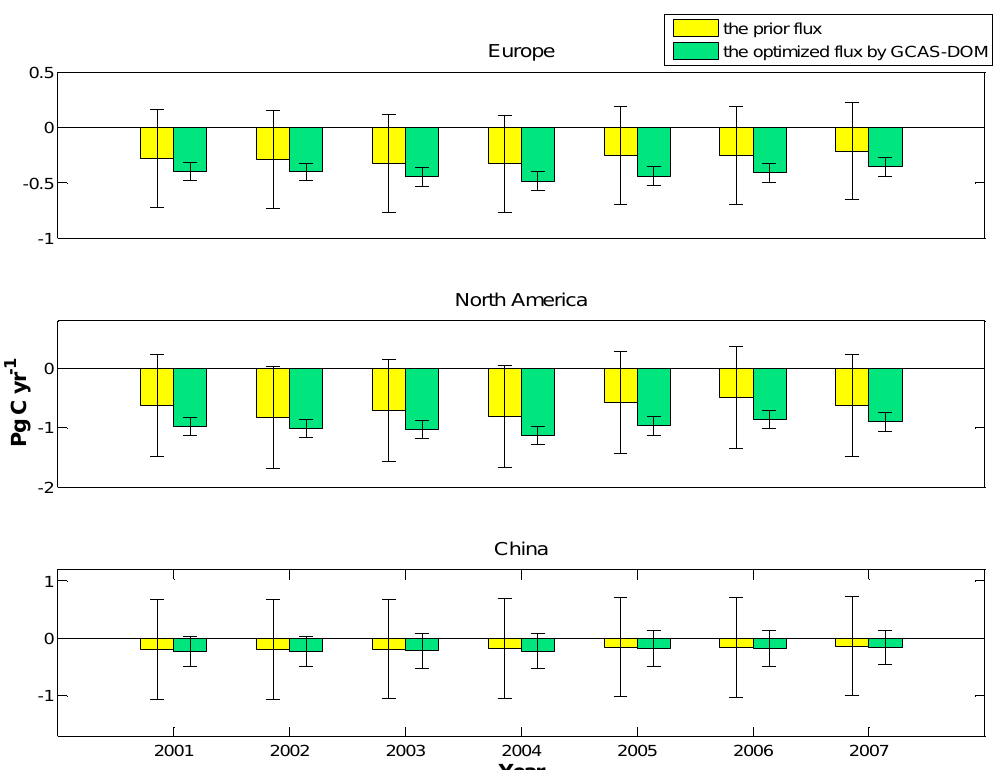
Figure 6. Fluxes and their uncertainties in three large regions before and after optimization from 2001 to 2007 (in PgCyr − 1 ): (a) Europe (b) North America (c)